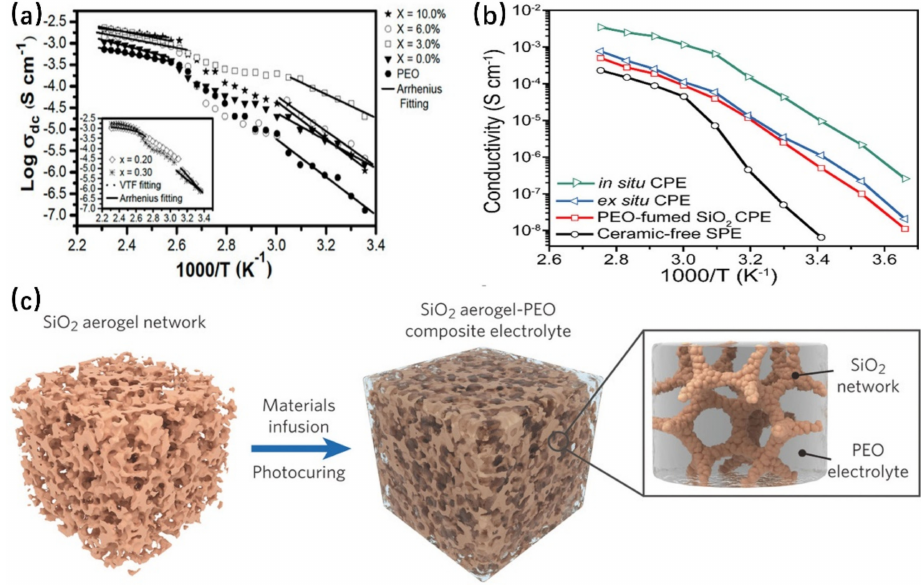
Figure 6. ( a ) The conductivity of the (PEO) 10 CF 3 COONa polymer electrolyte. The (PEO) 10 CF 3 COONa+x wt.% Al 2 O 3 composite electrolyte is inversely proportional to temperature. Solid lines represent Arrhenius fit, and dashed lines represent Vogel − Tammann − Fulcher (VTF) fit (Reprinted with permission from [72]; Copyright 2019, Materials (Basel)). ( b ) Arrhenius diagram of ionic conductivity between the PEO composite electrolyte containing SiO 2 and the contrast sample (Reprinted with permission from [74]; Copyright 2017, Powder Technology). ( c ) Schematic diagram of the synthesis process of aerogel skeleton silica and PEO (Reprinted with permission from [75]; Copyright 2018, Advanced